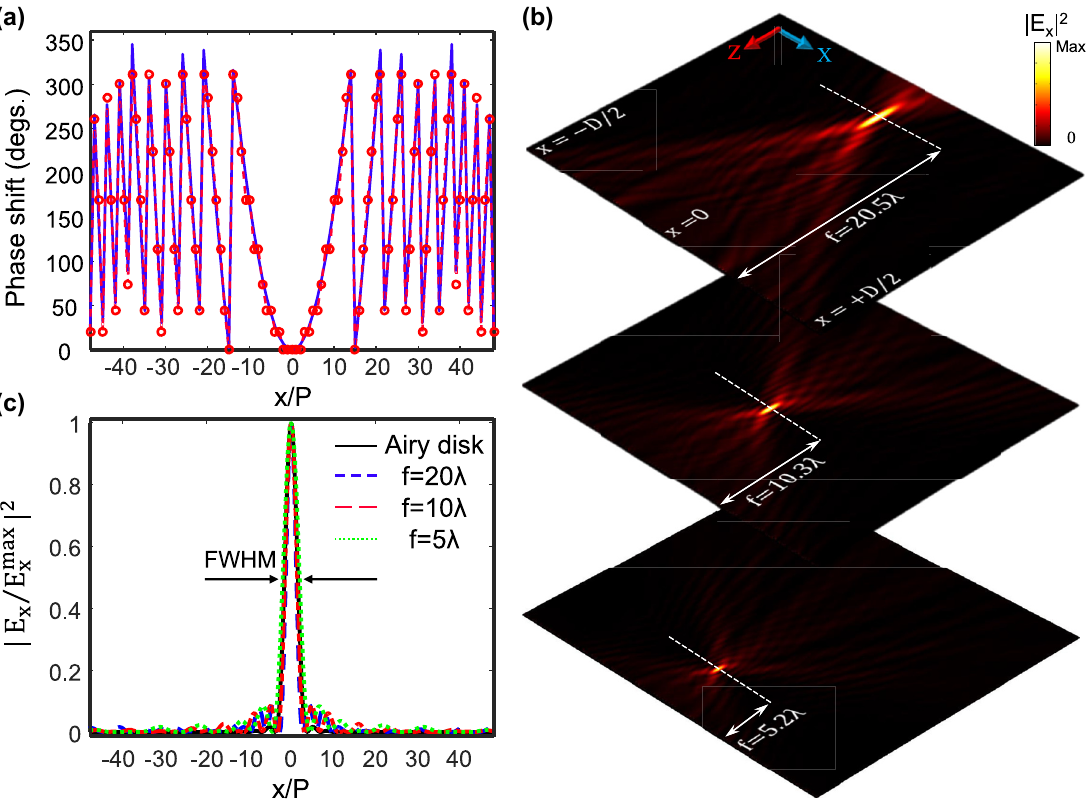
Figure 5: Performance of a reconfigurable metalens with diverse focal lengths. (a) The desired (solid blue line) and realized (red circles) phase discontinuities to implement metalens with the focal length of 20 𝜆 . (b) Calculated intensity profiles of the reflected beam by the tunable metalens in the transverse cross section for nominal focal lengths of (top) f = 20 𝜆 , (middle) f = 10 𝜆 , and (bottom) f = 5 𝜆 . (c) Comparison of the Airy disk intensity (solid black line) with the squared normalized amplitude of the electric field calculated at the distances of f = 20 𝜆 , f = 10 𝜆 , and f = 5 𝜆 (dashed lines). The lateral dimension of lenses is D = 100p, and the dashed horizontal lines in (b) indicate the focal plane. The wavelength of the linearly-polarized incident light is 𝜆 = 1550